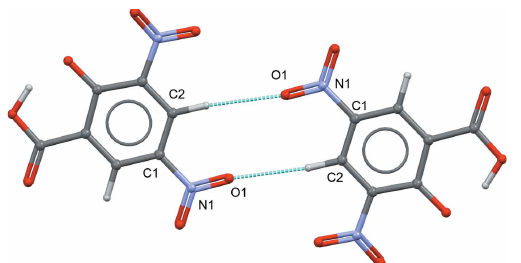
Figure 4 Part of the crystal structure of (I) showing the centrosymmetric dimer motif with the R 2 (10) motif formed by the C2—H2 (cid:2)(cid:2)(cid:2) O1 interaction. 2